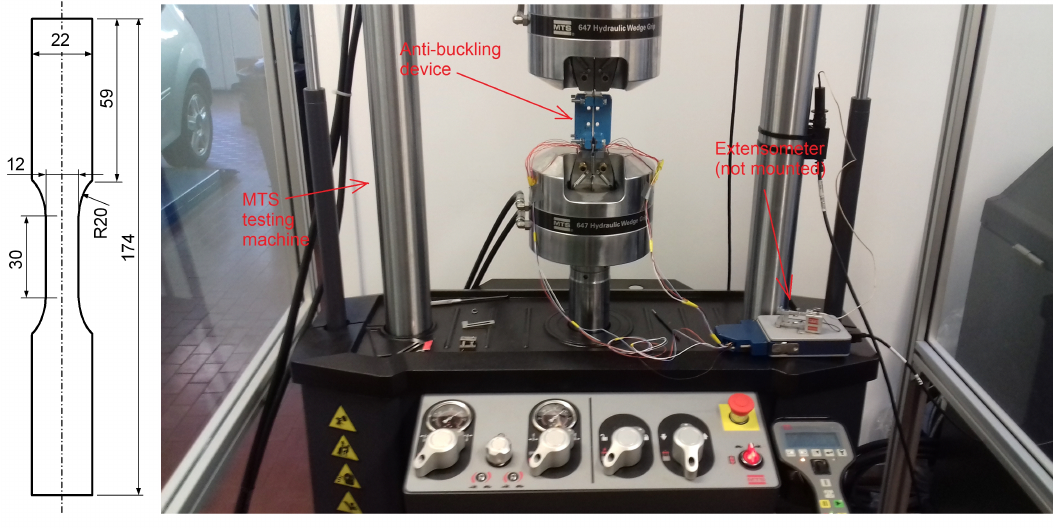
Figure 7. A specimen shape (left) and a low-cycle fatigue experimental arrangement